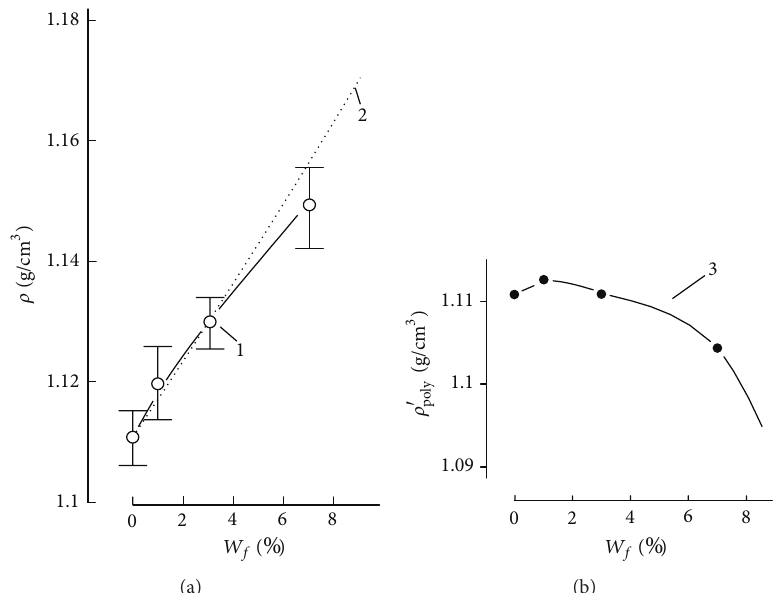
Figure 5: Density 𝜌 (a) of PU and PU/OMMT nanocomposites as a function of the OMMT weight content 𝑊 𝑓 : 1—experimental data, 2— calculation by the additivity equation (2) and 3—apparent density (b) by (3).